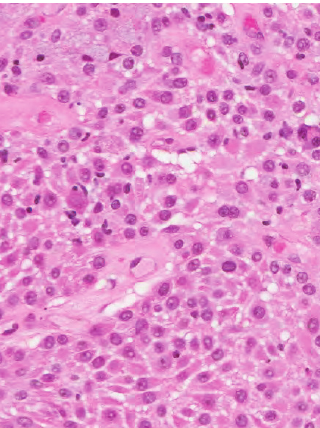
Figure 3: Histopathology shows benign squamous cells consistent with the diagnosis of squamous papilloma. Negative for dysplasia, malignancy, or granuloma.